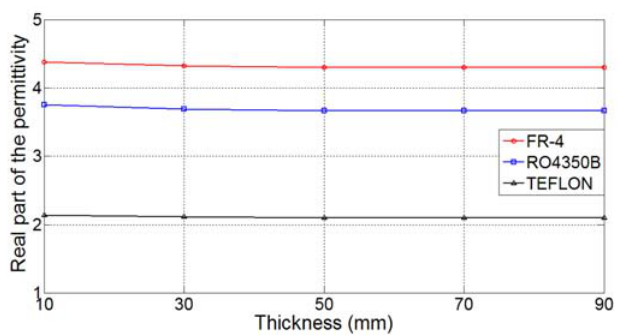
Figure 8: The real part of the complex relative permittivity of material samples is estimated by the MUSIC